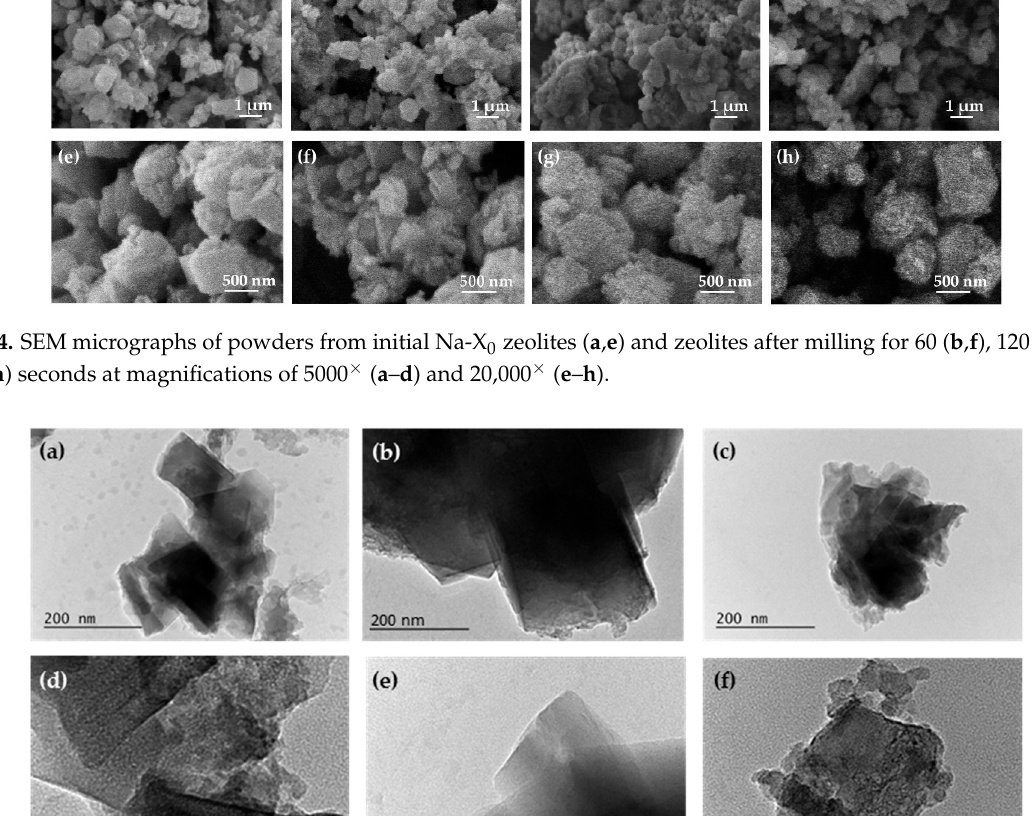
Figure 5. TEM images of non ‐ milled NaX 0 ( a , d ), short ‐ milled Na ‐ X 60 ( b , e ), and long ‐ milled Na ‐ X 540 ( c , f ) zeolite samples.